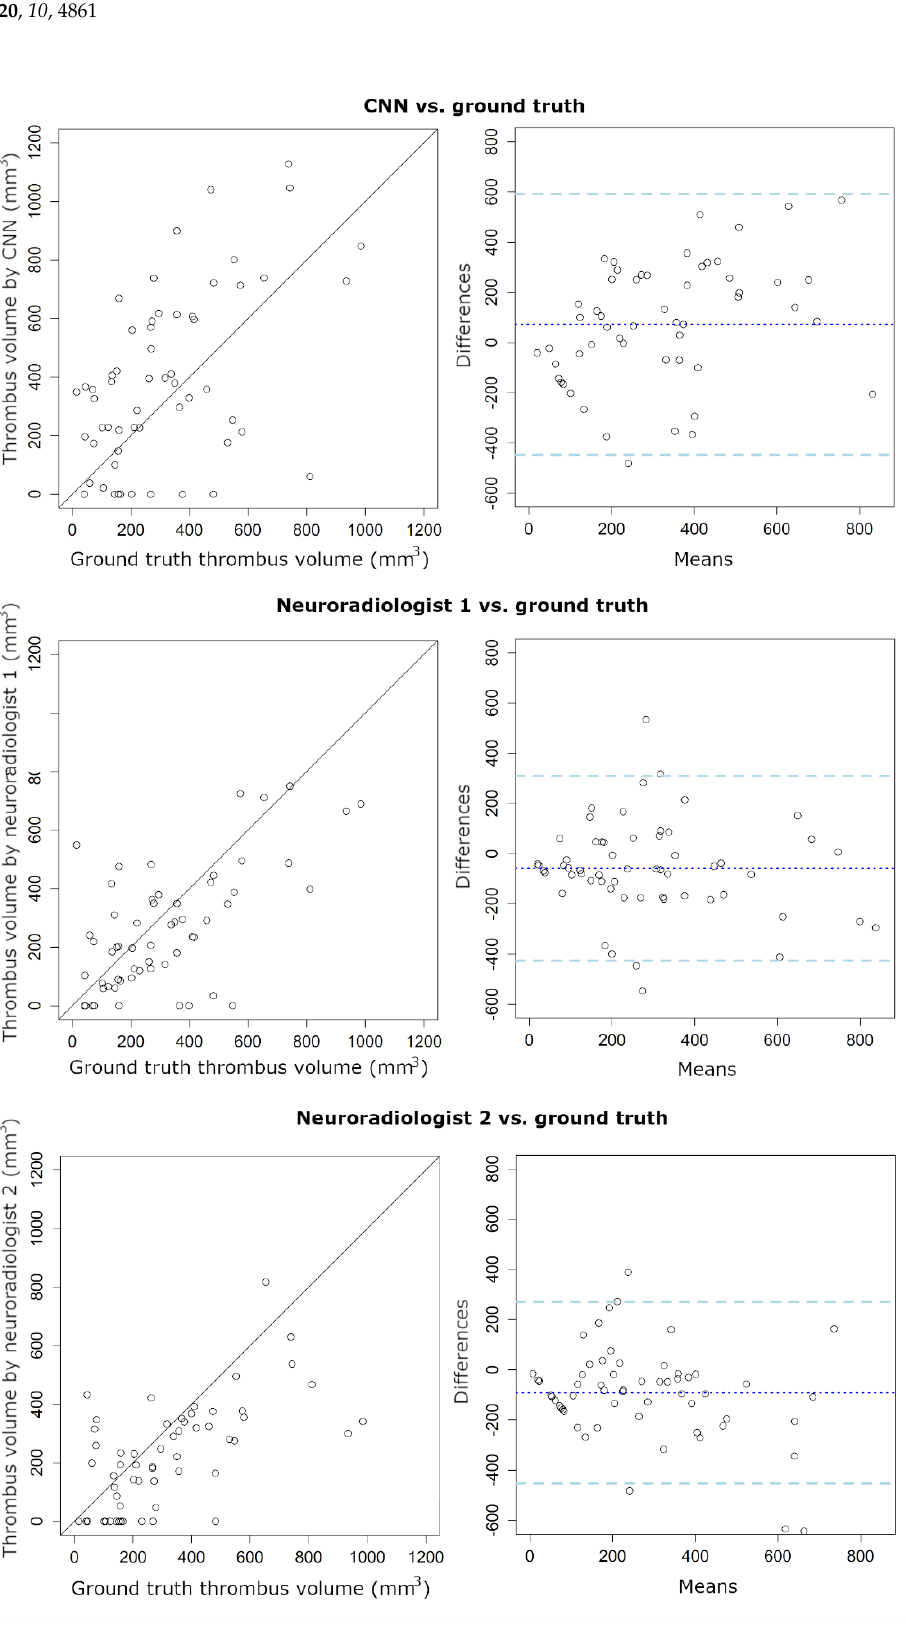
Figure 2. An example of the segmentation results. ( A ) Original non-contrast computed tomography (NCCT); ( B ) Segmentation made by one of the neuroradiologists; ( C ) Segmentation acquired by the CNN.